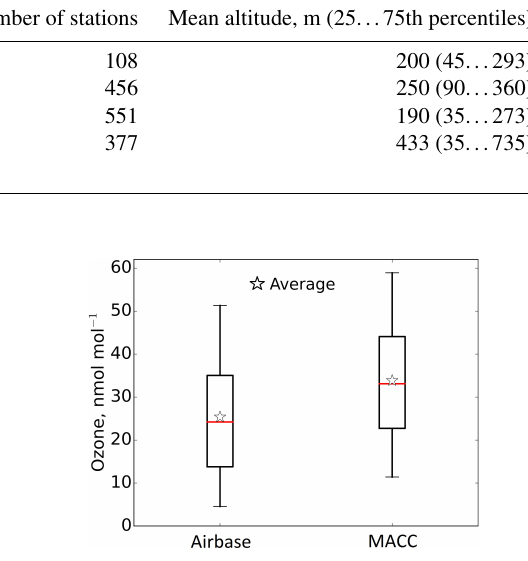
Figure 5. Percentiles (5–25–50–75–95) of 3-hourly ozone mixing ratios for 1492 stations; Airbase vs.